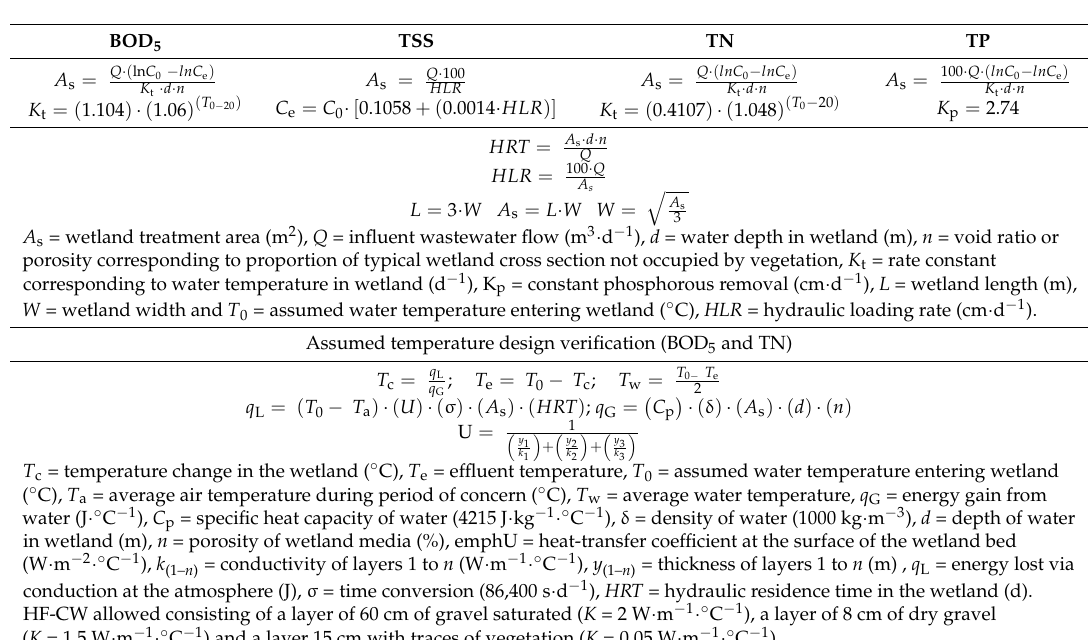
Table 4. HF-CW design models for temperatures greater than 1 ◦ C according to Reed, Crites and Middlebrooks [59].